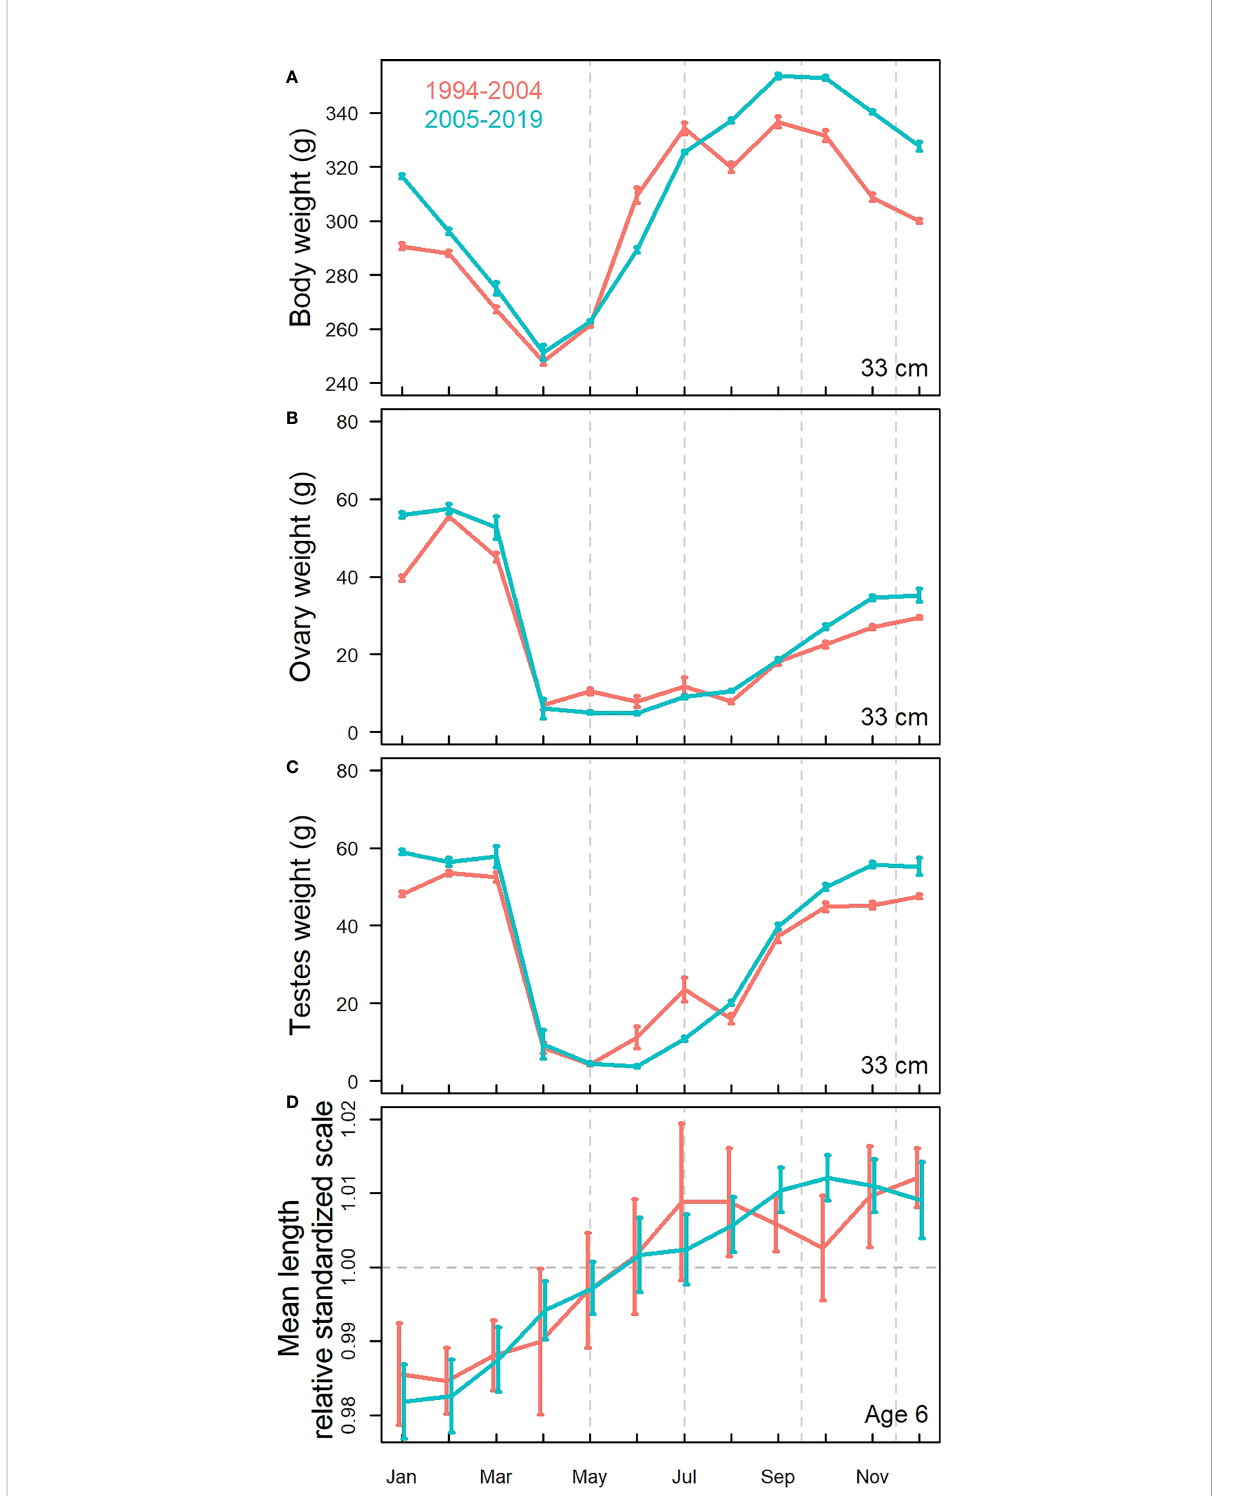
FIGURE 6 Seasonal variation based on raw data summaries showing monthly development in (A) weight (standardized at 33cm length) and gonad weight (standardized at 33 cm length) for (B) females (ovaries) and (C) males (testes) and (D) standardized mean length compared between the periods before (red) and after (green) 2005. The error bars indicate 95% con fi dence intervals of the